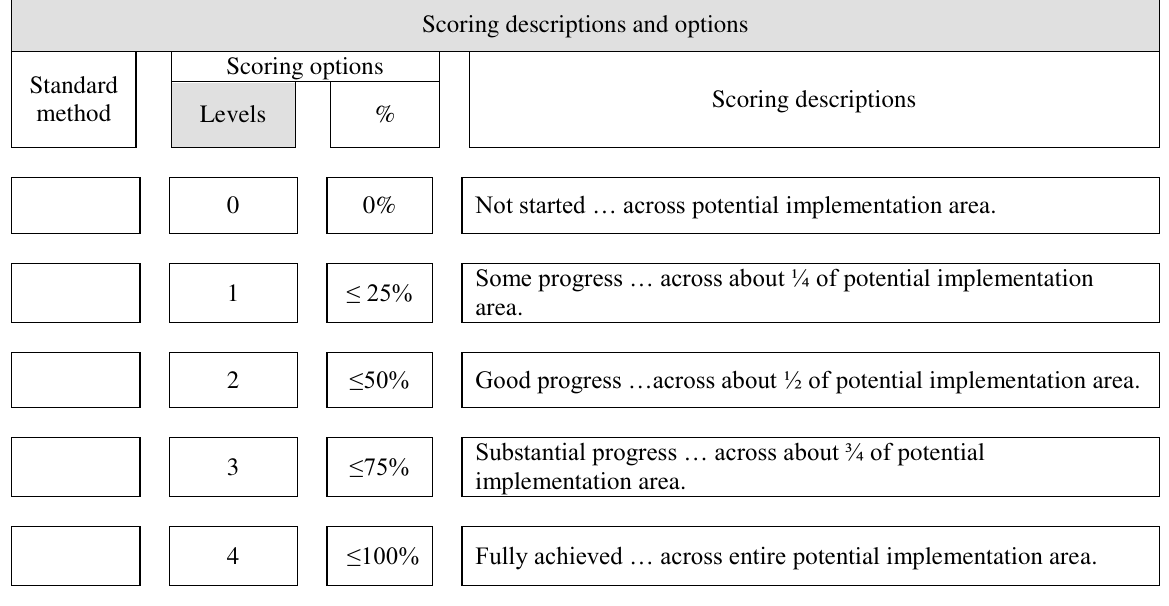
Source: Adapted from Ladzani (2009, p.